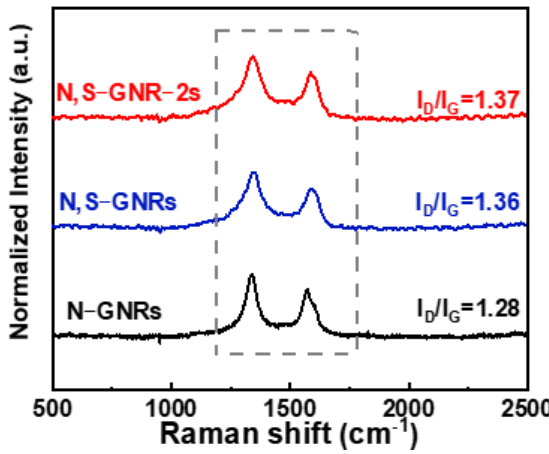
Figure 3. The Raman spectra of N − GNRs, N, S − GNRs and N, S − GNR − 2s. Electrochemical tests of N, S − GNR − 2s were carried out in an alkaline medium of 0.1 M KOH. Three samples of N, S − GNR − 2s with different thermal annealing temperatures (800 °C, 900 °C and 1000 °C) were examined, among which, N, S − GNR − 2s at 900 °C showed the best ORR activity (Figure S1). For this reason, this sample was selected in the following experiments for the performance analysis. Figure 4a displays CV curves of N, S − GNR − 2s in O 2 and N 2 − saturated solution. No evident peaks appeared when tested in N 2 − saturated solution, whereas a distinct ORR peak in O 2 − saturated solution was clearly observed at 0.80 V, suggesting good ORR catalytic activity for N, S − GNR − 2s. RDE meas- urement was carried out at different rotating speeds from 625 to 2500 rpm (Figure 4b), and Koutecky – Levich (K – L) plots are correspondingly displayed in Figure 4c. The elec- tron transfer number was extracted to be 3.66~3.67, ranging from 0.3~0.6 V. In addition, RRDE testing was further performed in order to accurately detect the generation of per- oxide (HO 2 − ) during the reaction (Figure 4d). The average HO 2 − yield was measured and calculated to be about 13.69%, and the average electron transfer number was calculated to be about 3.72 from 0 to 0.8 V (Figure 4e), in correspondence with the result in Figure 4c. The electrocatalytic properties tested by RDE and RRDE distinctly verified that N, S − GNR − 2s mainly displayed a 4 − electron catalytic pathway towards an ORR. RDE curves at 1600 rpm before and after 2000 CV cycles with a scan rate of 100 mV s −1 and potential range of 0.56~0.96 V are shown to evaluate the stability of N, S − GNR − 2s (Figure 4f). The diffusion − limited current density after cycling stayed almost unchanged, and the half − wave potential (E 1/2 ) slightly shifted from 0.79 V to 0.71 V, demonstrating the decent ORR stability of our catalysts.